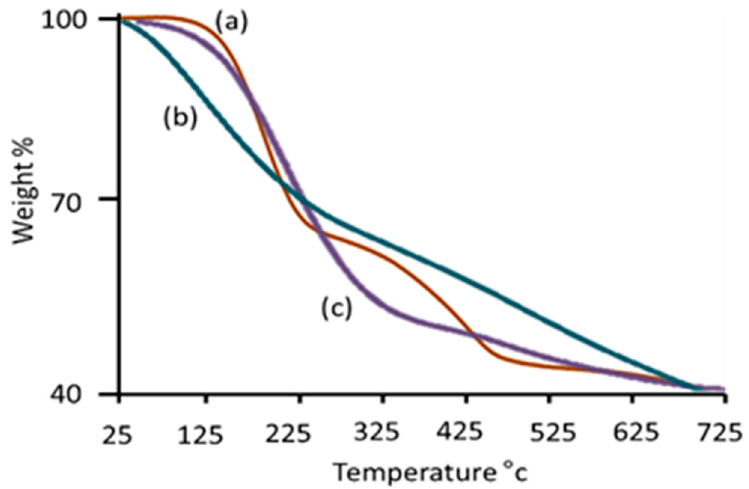
Figure 6. TGA thermogram of ( a ) CF-OH, ( b ) CF-SH, and ( c ) CF-SH-Hg.